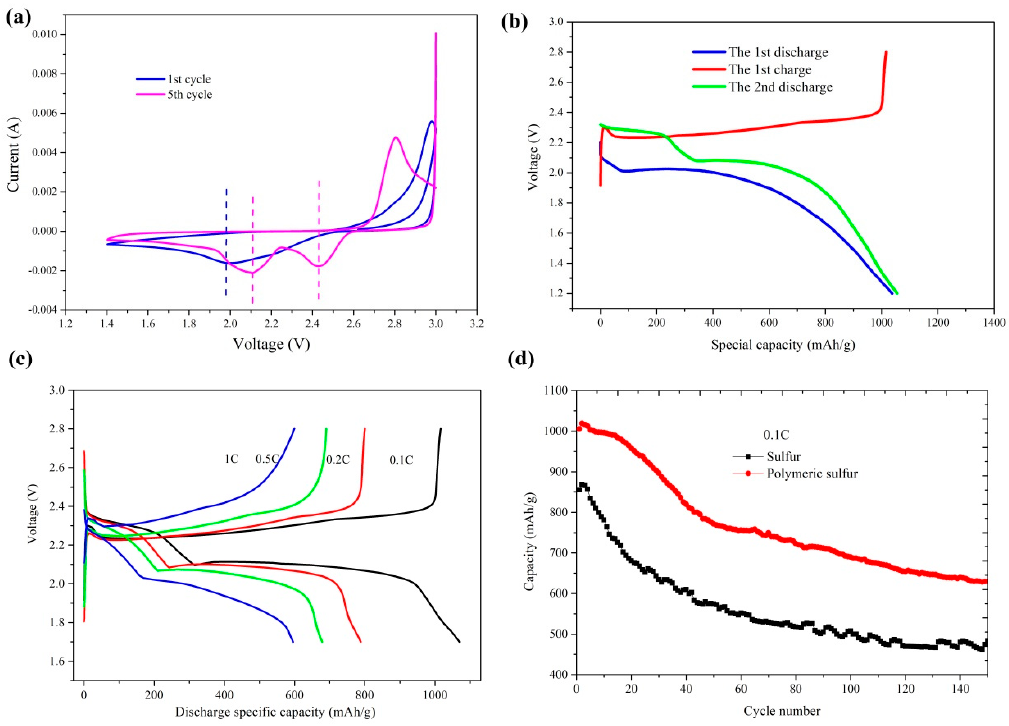
Figure 4. ( a ) CV curves of the polymeric sulfur in the first and fifth cycle between 1.4 V and 3.0 V